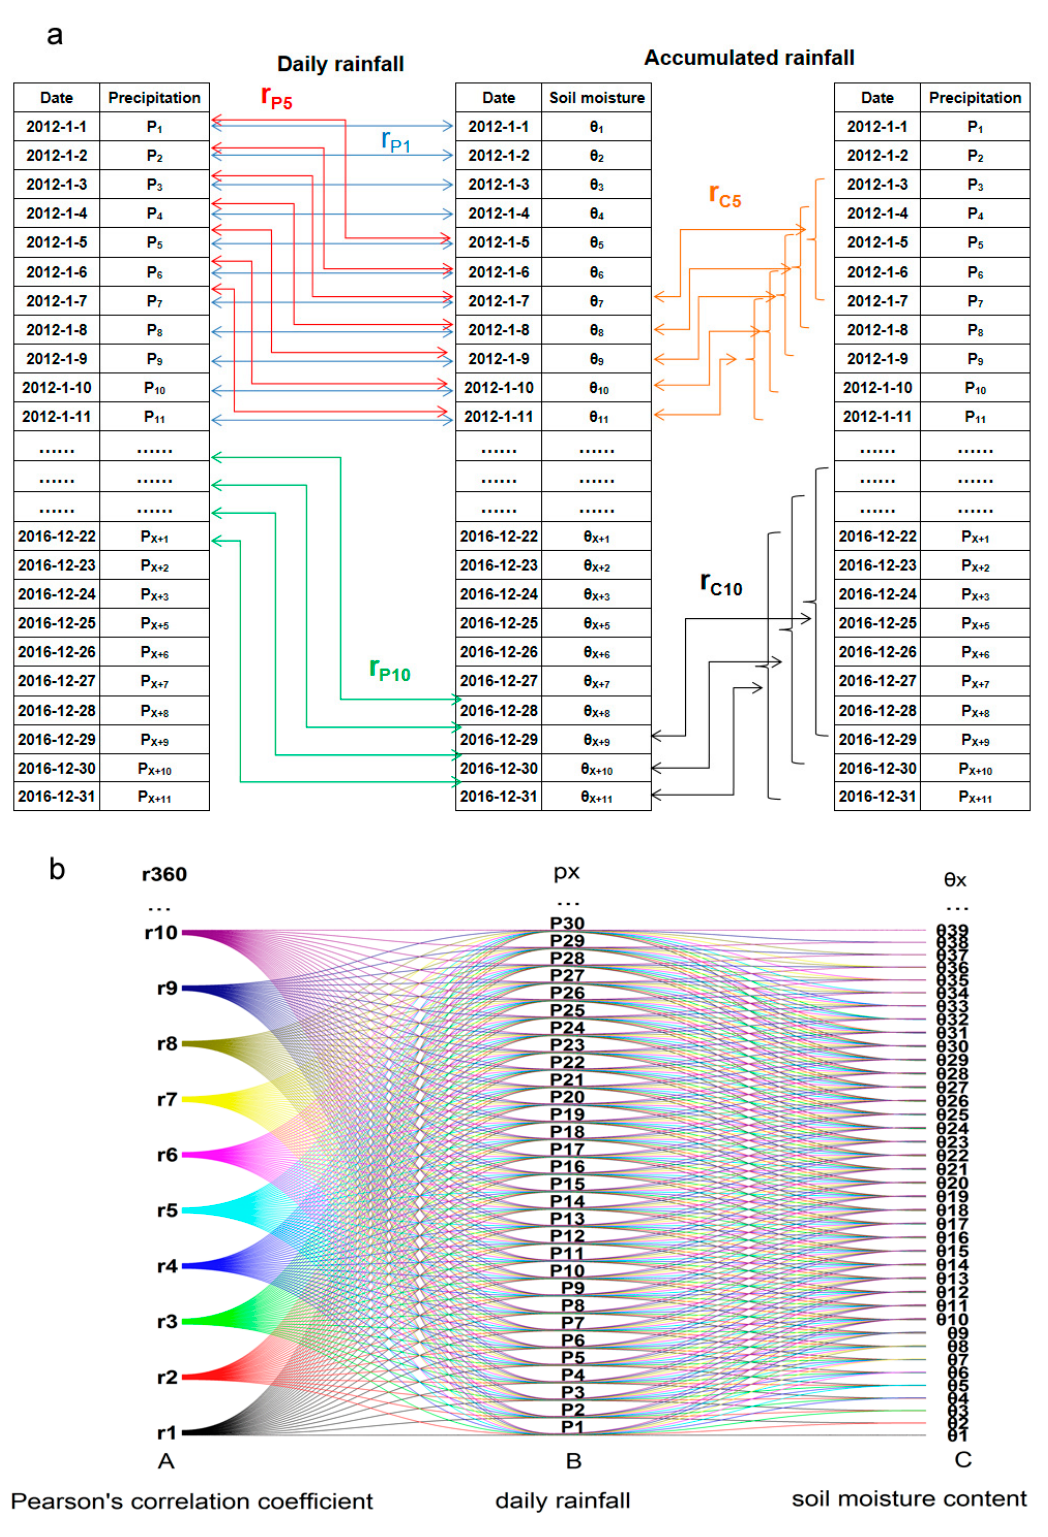
Figure 3. ( a ) Plot of Pearson’s correlation coefficient between soil moisture content and daily accu- mulated precipitation based on time series to rp1, rp5, rp10, rc5, and rc10for example. ( b ) Pearson’s correlation coefficient r (r1, r2, r3,..., r360) between soil moisture content and daily precipitation big data graph.